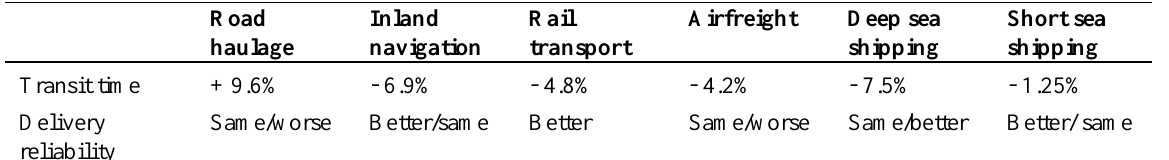
Table 5. Average expectations regarding transit times and reliability in 2010, compared to